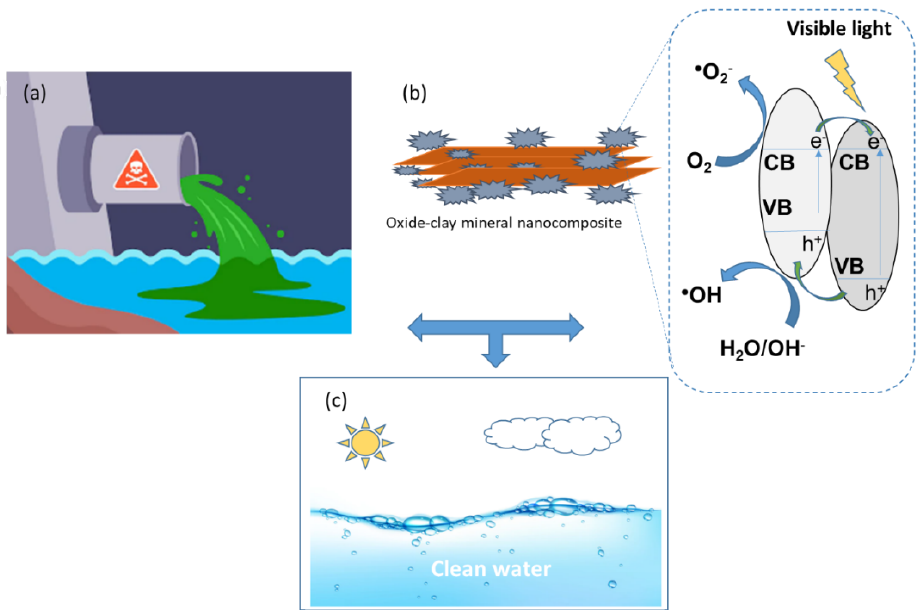
Figure 8. Representative scheme in sequence of the ( a ) polluted wastewater, ( b ) oxide – clay mineral nanocomposite reaction mechanism in the photocatalytic degradation of organic compounds and ( c ) clean water after treatment.